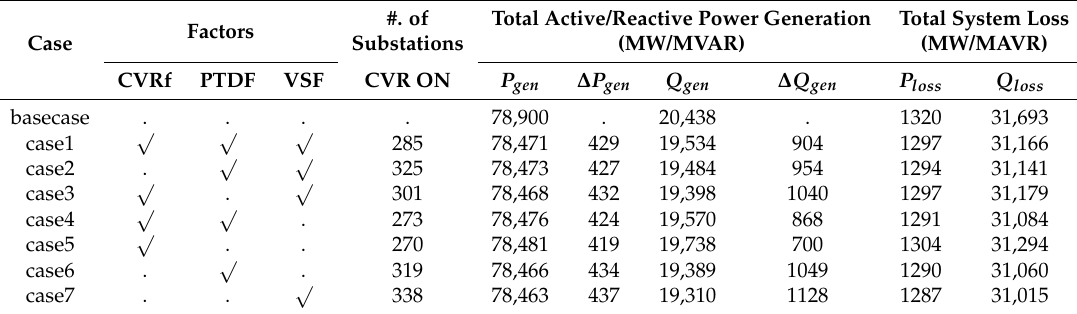
Table 9. CVR Results for the Korean electric power